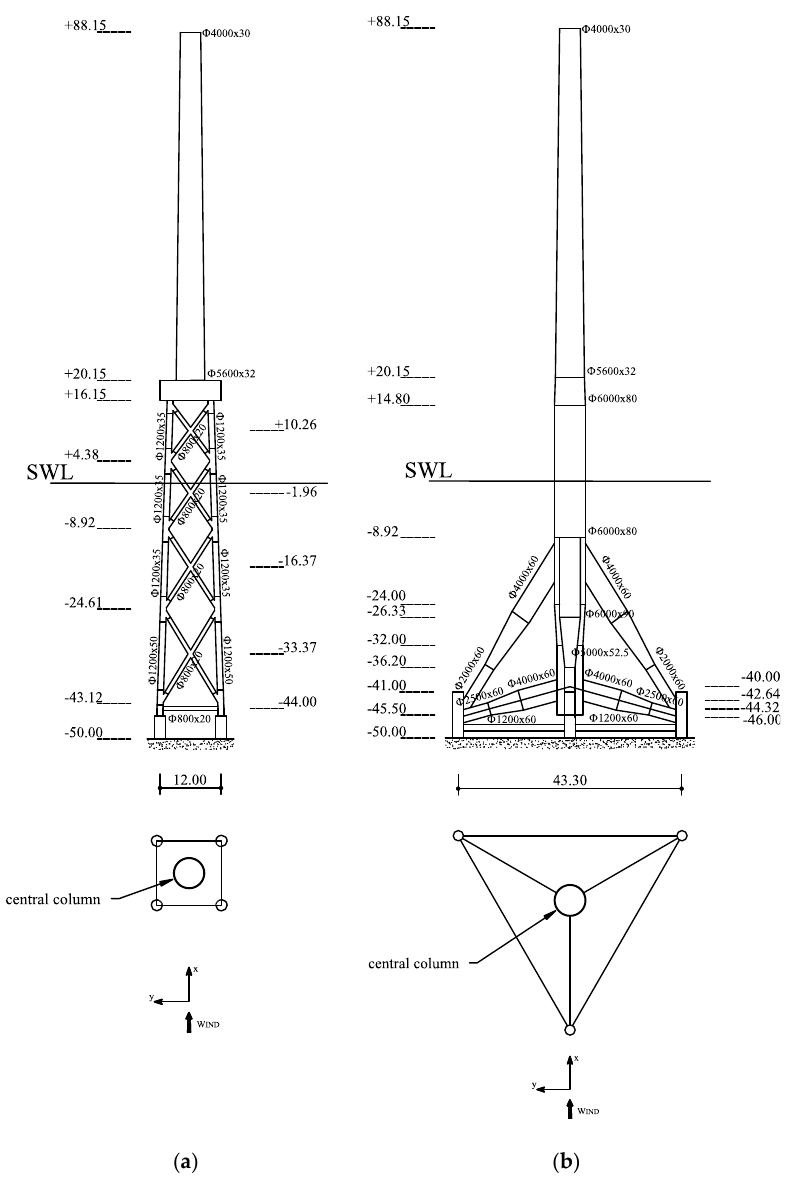
Figure 2. Geometry of ( a ) Jacket and ( b ) Tripod (dimensions of structural members in mm; heights and depths in m).